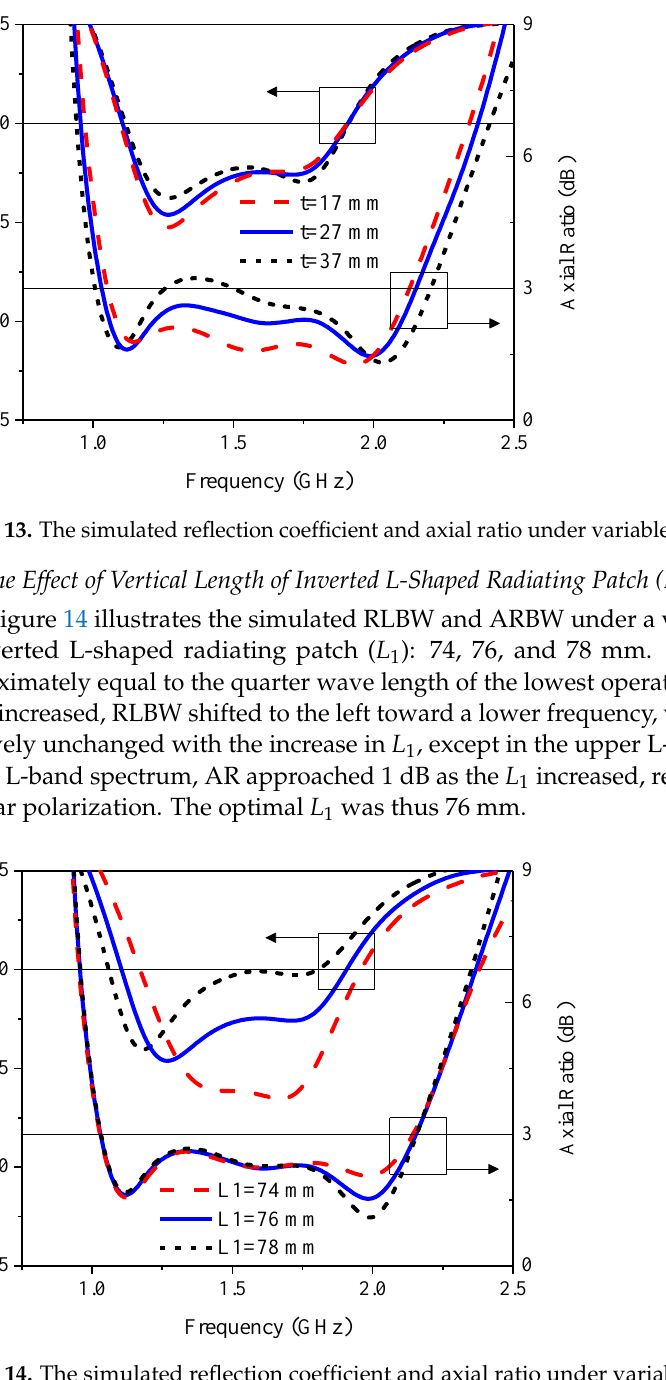
Figure 14. The simulated reflection coefficient and axial ratio under variable vertical length ( L 1 ) of the radiating patch.